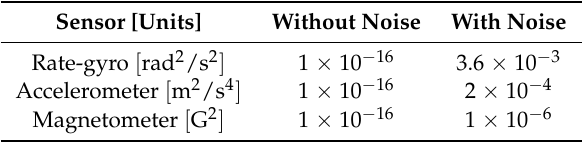
Table 1. Sensor variance